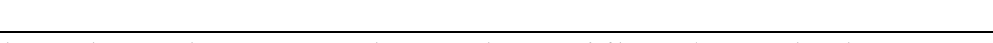
Fig. 4 Characterization of the GalNAc-T2 chimeras and mutants. a MD simulations in explicit water of chimera 2 (500 ns total simulation time; water molecules were removed for clarity). The 28 ns time-lapse snapshots show the dynamic events occurring during the lectin domain reorientation observed for this chimera. The GalNAc-T2 (far left) and GalNAc-T4 (far right) crystal structures are shown as references for the initial and fi nal states. All structures are illustrated in a surface view with two different orientations. The lectin and catalytic domains, and the fl exible linker of GalNAc-T2 and GalNAc-T4 are depicted as yellow/purple blue, orange/light gray, and red/deep teal, respectively. The colors used for the chimera 2 and GalNAc-T2 are the same except for the fl exible linker of the former, which is pale green. Flexible linkers are also shown at the bottom in a cartoon- and sticks-like view. b Glycosylation time course plots of GalNAc-T2 and the GalNAc-T2 chimeras and mutants against (glyco)peptides 1 – 3 at substrate concentration of 1.4 mM. The obtained speci fi c activities and selected substrate activity ratios are given in Supplementary Fig. 9. c Complete glycosylation kinetics (initial speci fi c activity versus substrate concentration) for GalNAc-T2, the GalNAc-T2-triple mutant and the GalNAc-T2 chimera 3 against substrate (glyco)peptides 1 – 3 (top panels) with plots of the obtained Michaelis – Menten kinetic parameters, K m , V max , catalytic ef fi ciency ( V max / K m ), and catalytic ef fi ciency ratios (monoglycopeptide 2 over 3 ) (bottom panels). Kinetic parameter values are summarized in Supplementary Table